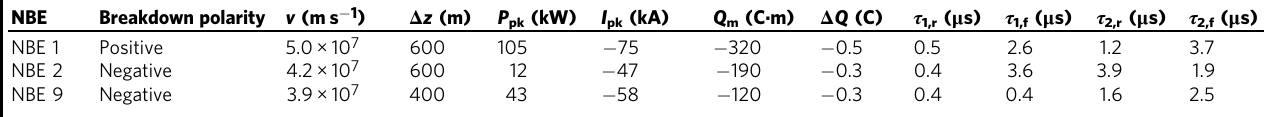
The polarity is that of the initial fast breakdown of each NBE, and does not correspond to the sferic polarity. v is the INTF-determined speed of the fast breakdown, Δ z is the INTF-determined vertical extent of the fast breakdown, and P pk is the LMA-determined peak source power. I pk and Q m correspond to the peak current and charge-moment change during fast breakdown, as determined from FA sferic simulations similar to those in Rison et al. 8 , and Δ Q is the charge transfer. Two double-exponential current pulses were used to simulate each sferic. The fi rst and second current pulses have rise and fall e -folding times of τ 1,r , τ 1,f , and τ 2,r , τ 2,f ,